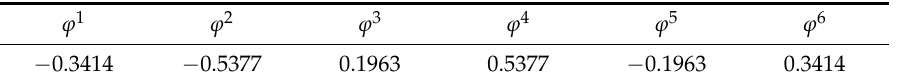
Table 5. The comprehensive concordance/discordance